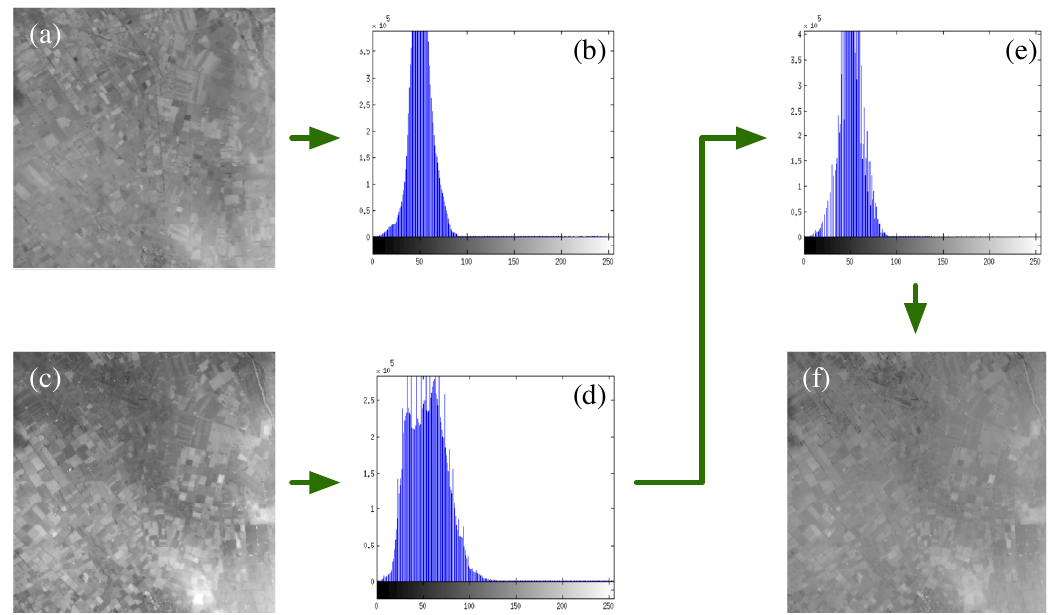
Figure 4. Global histogram matching: ( a ) reference image; ( b ) histogram of ( a ); ( c ) sensed image; ( d ) histogram of ( c ); ( e ) global histogram matching; and ( f ) histogram matched image. Algorithm 1 shows the flow of local histogram matching. The procedure is same as done in the case of global histogram matching; however, here, histograms of blocks (Figure 5a,d: the block-wise reference and sensed image) are matched instead of histograms of entire images (Figure 4a,c).